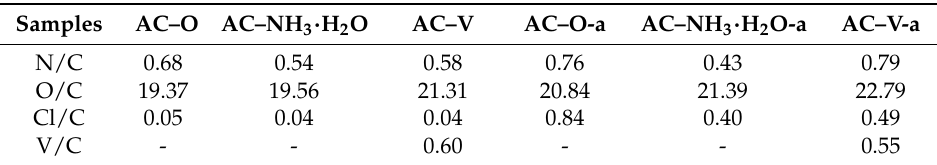
Table 2. Summary of elemental composition and high ‐ resolution C 1s and O 1s spectra of different catalysts before and after reaction.